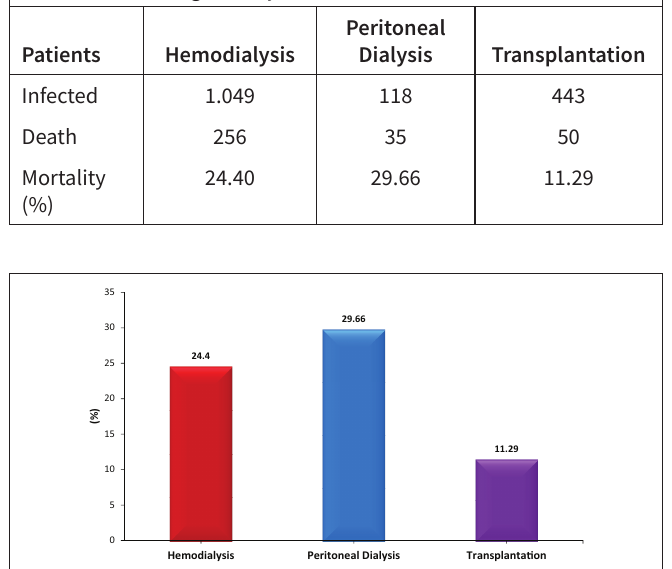
Table 3. Mortality Rate of Kidney Replacement Therapy Patients with COVID-19 Diagnosis by Modalities